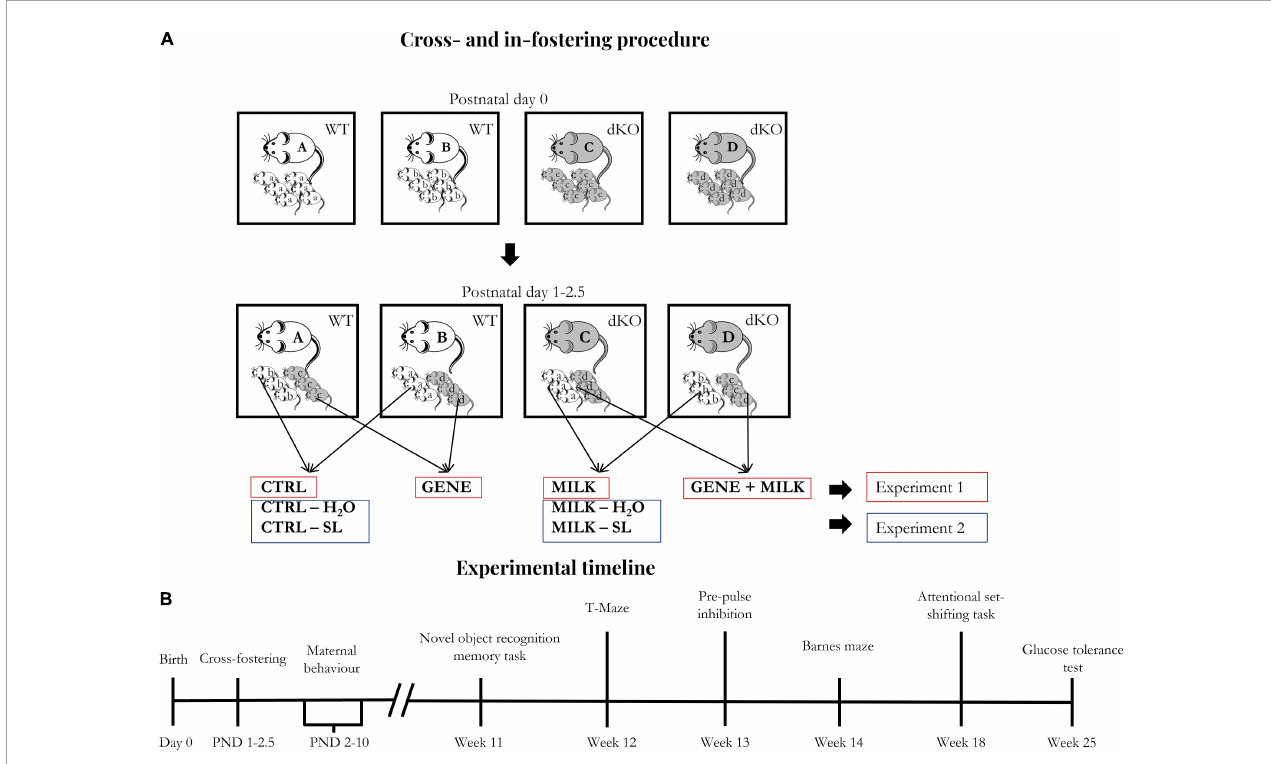
FIGURE1 (A) Fostering scheme: Starting one day after birth, cross- and in-fostering procedures were performed as sketched in the lower panels. Dams remained in their home cages while offspring were transferred from their original cages to those housing their foster dams. At the end of fostering procedures, litters consisted of WT and dKO mice in a 1:1 ratio. Importantly, no pup was reared to its biological dam. (B) Experimental timeline: The day of birth was designated as day 0. The experimental procedures started between post-natal days (PND) 1 and 2.5 (cross- and in-fostering procedures).